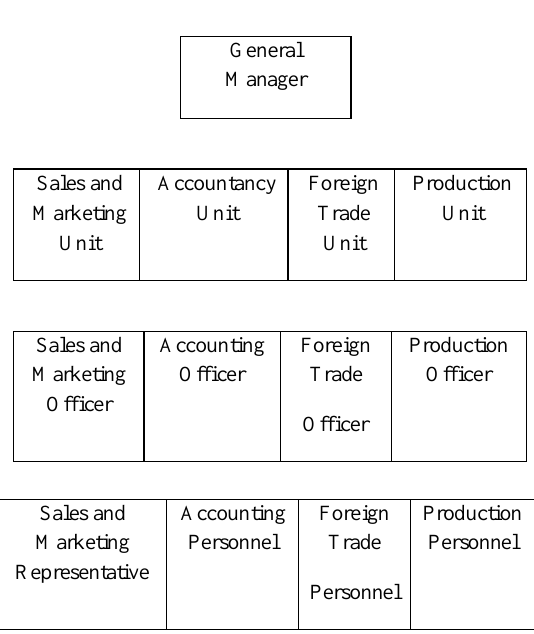
Figure 1. Organizational Diagram of XYZ Enterprise